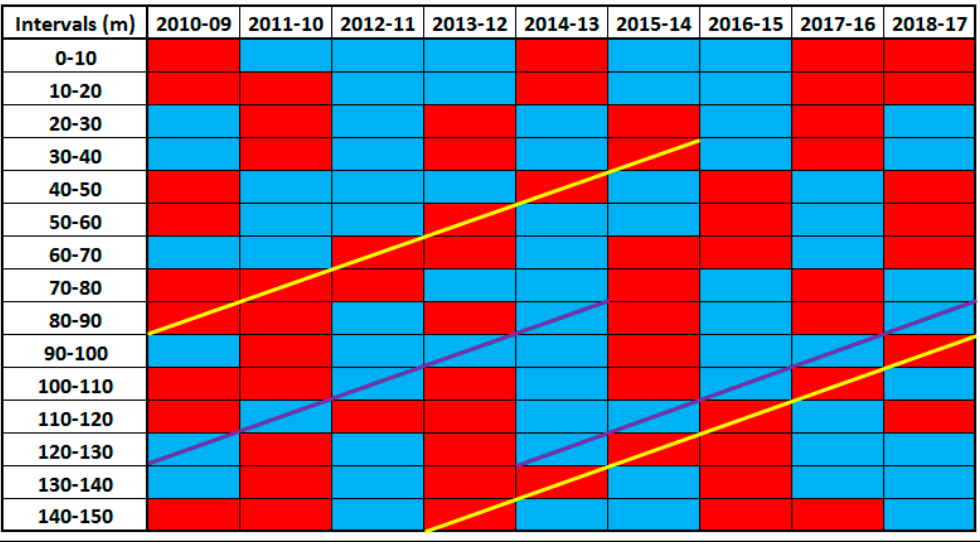
Figure 6. Annual evolution of profile 3 of cone A for intervals of distances of 10 m. The values in Figure 5 coincide with the column of the annual period 2011–10. The purple lines correspond to the temporal evolution of thickening of material in the profile, while the yellow lines indicate thinning.